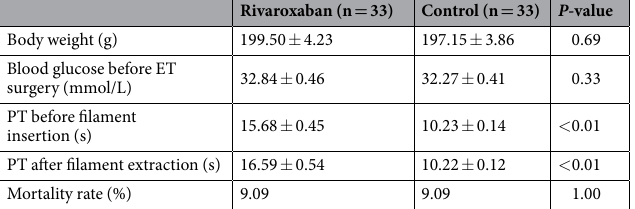
Table 1. Physiological parameters in two experimental groups. PT, prothrombin time.